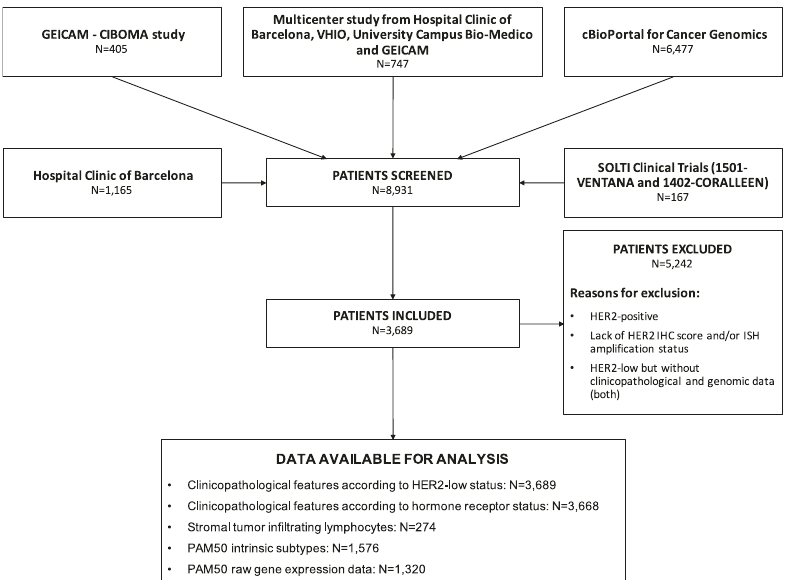
Fig. 1 STROBE fl ow-chart. Flow-chart resuming the patient selection process, showing causes for exclusion and the number of patients with available data for the main analyses presented in the study. GEICAM Grupo Español de Investigación en Cáncer de Mama, CIBOMA Coalición